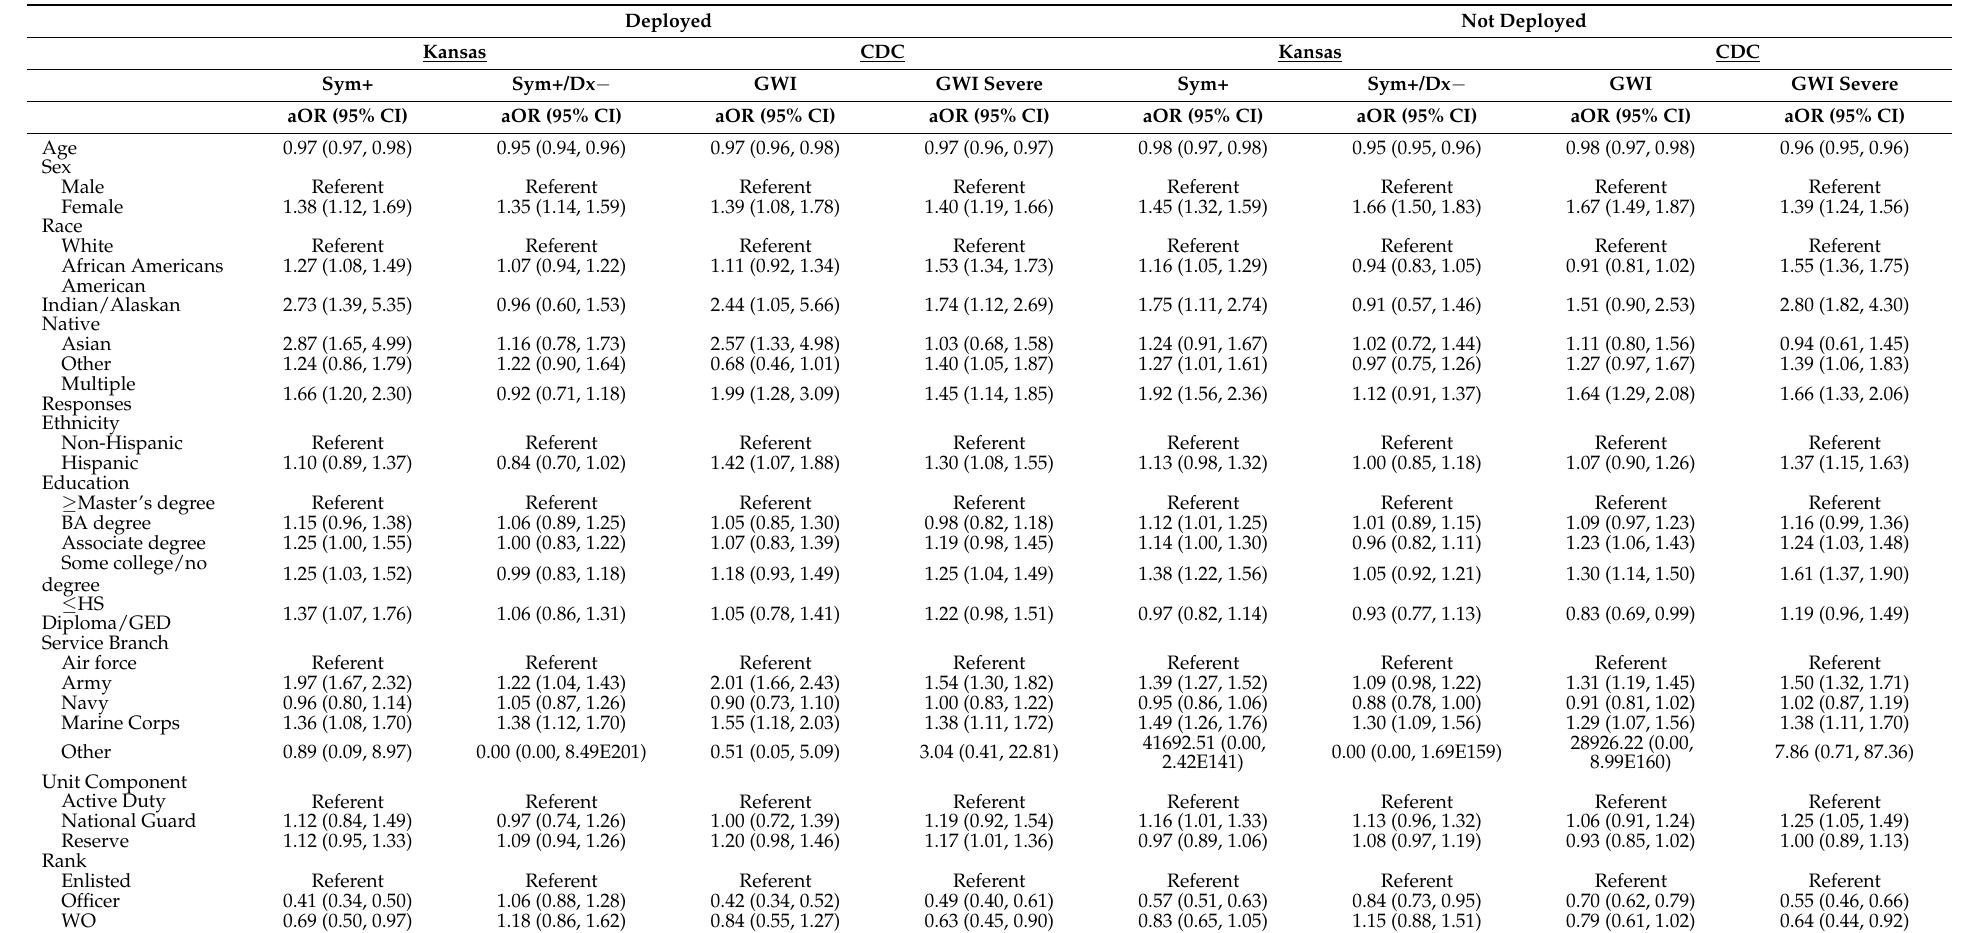
Table A9. Complete Case Analyses for Adjusted Associations of Gulf War Illness Phenotypes with Demographic Characteristics. Deployed Not